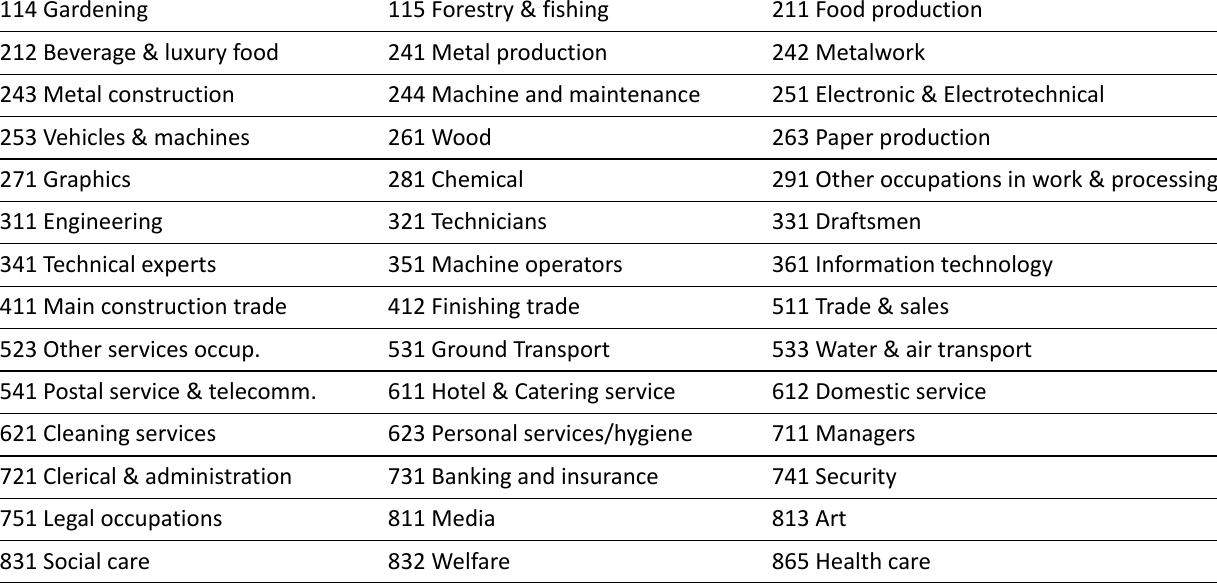
Table A1. Occupational groups based on SBN2000.